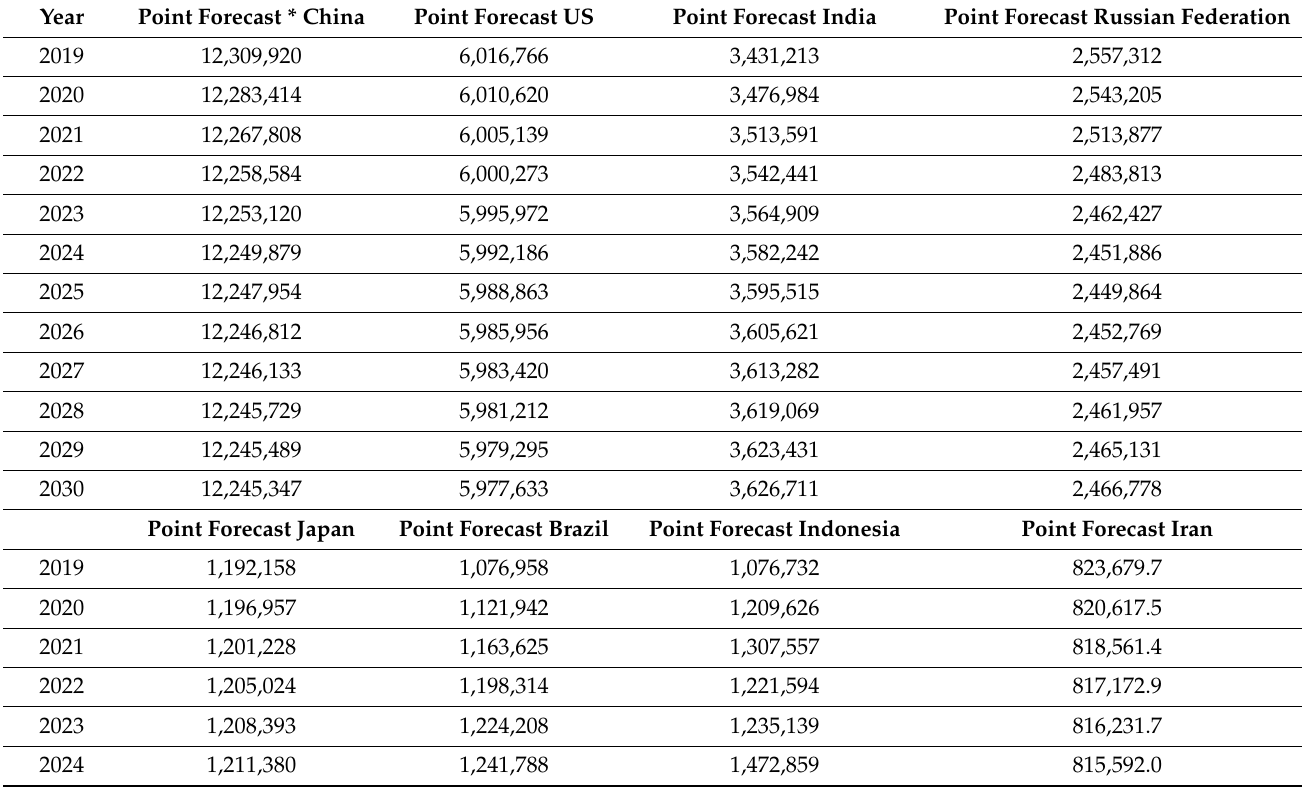
Table 6. Total GHG emissions in top polluting countries, kt of CO 2 tons (forecasted values for 2019–2030).